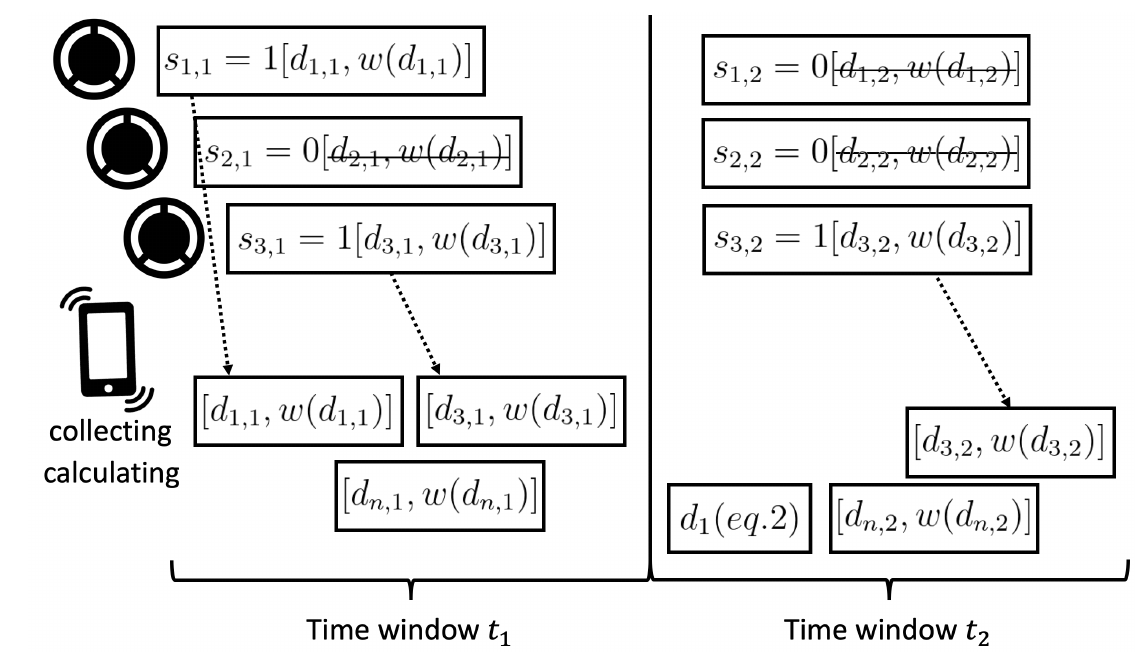
Figure 2. Cooperation of sensor nodes in proposed personal area network.